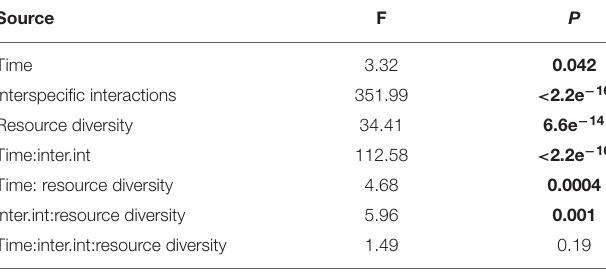
high-diversity compared to the medium-diversity food treatment ( p = 0.007) in real (multispecies) but not in fictitious assemblages (both p >